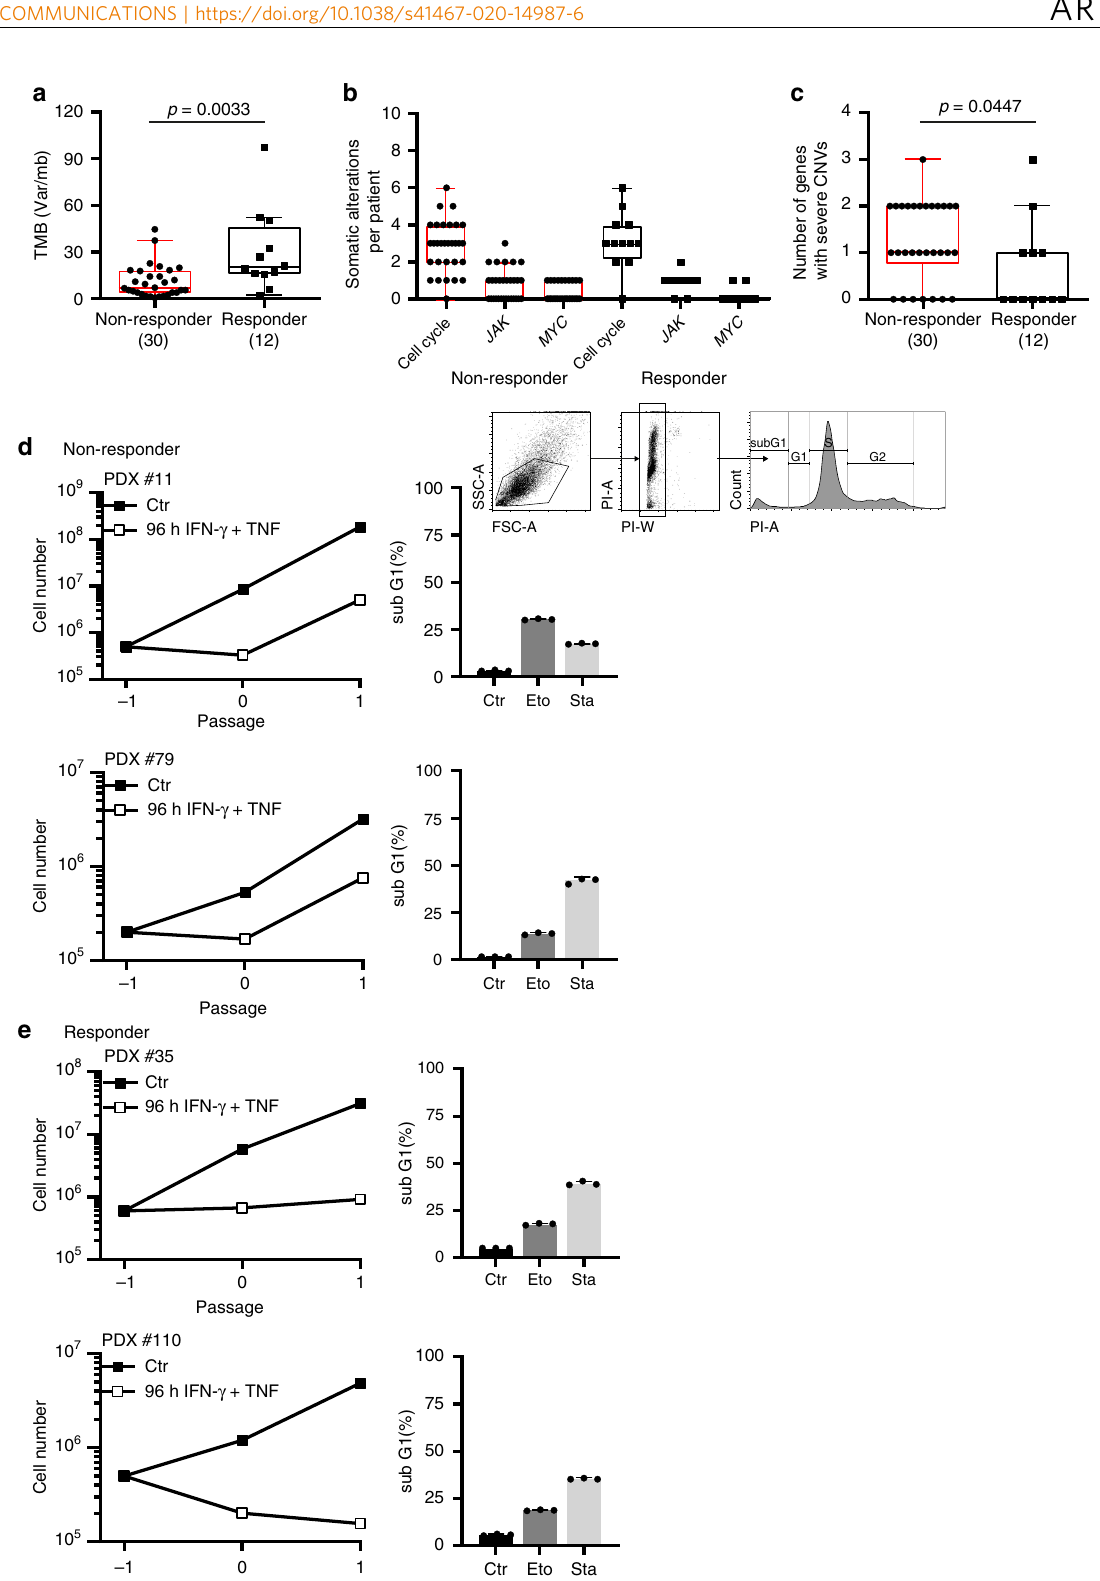
EndoFreeMaxi Kit. 66 The primary RT2-cell lines were transfected using the Quiagene Effectene Transfection Reagent. Generation of primary human melanoma cell lines . Melanoma tissue was cut into small pieces, digested in HBBS (w/o Ca 2 + and Mg 2 + ) with 0.05% collagenase, 0.1% hyaluronidase and 0.15% dispase, at 37°C for 1h and fi ltered through a cell strainer